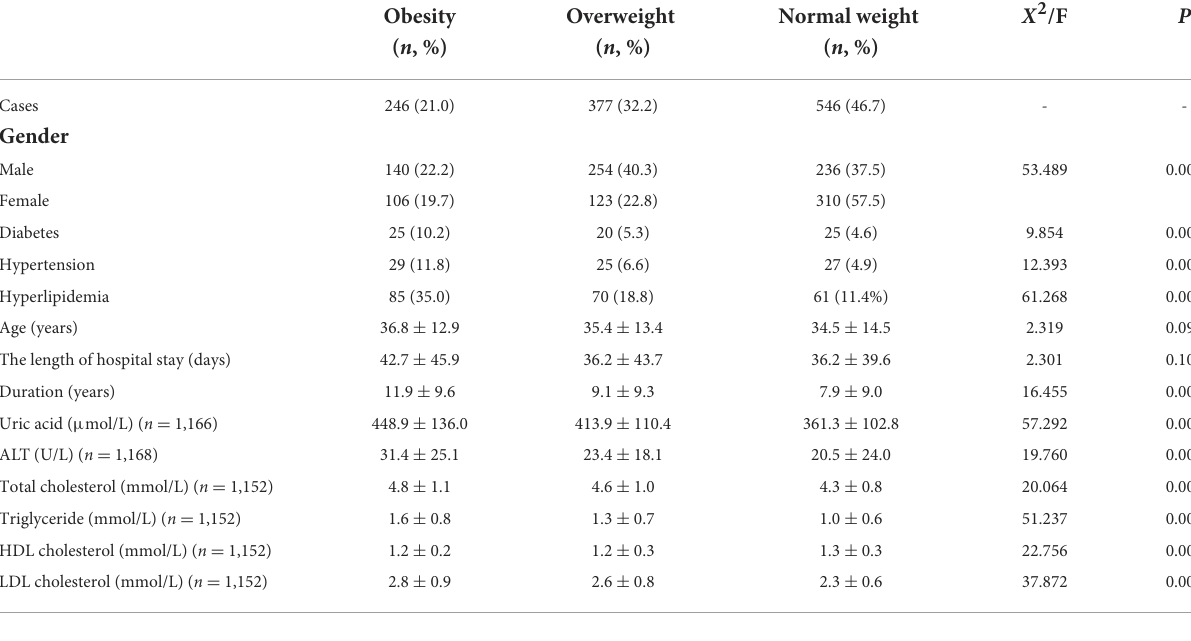
TABLE 1 Demographic and clinical characteristics of BD patients with obesity, patients with overweight and patients with normal weight.